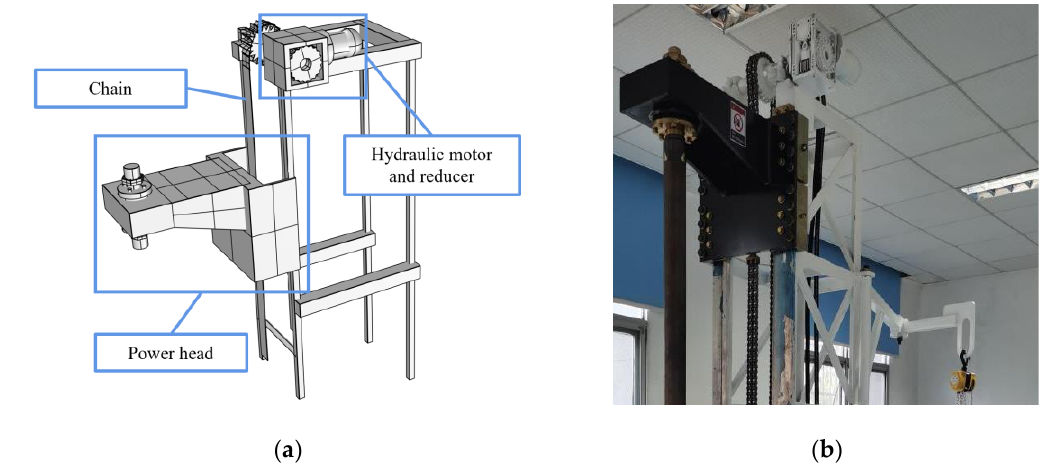
Figure 4. Model and physical drawing of the direct propulsion module. ( a ) Model drawing; ( b ) Physical drawing.